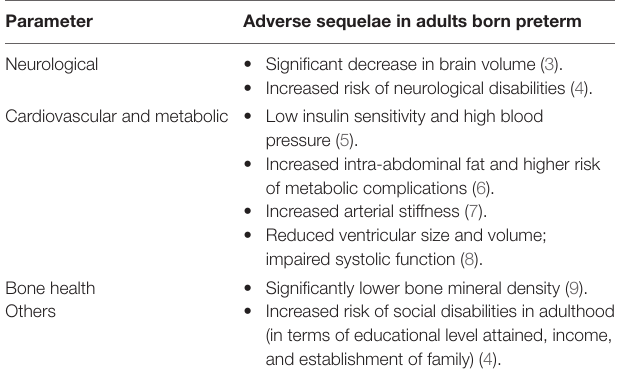
TaBLe 1 | adverse developmental sequelae in adults born